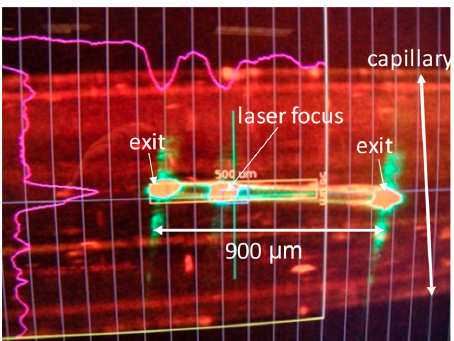
Figure 2. Screenshot of a photoactive yellow protein (PYP) crystal (pale yellow) displayed on a monitor at the XPP instrument of the LCLS during laser illumination. The crystal of size 900 × 40 × 40 μ m 3 is kept in a glass capillary. It is illuminated by a femtosecond laser pulse (laser focus). The crystal apparently acts as a waveguide, with the laser light exiting at both ends.